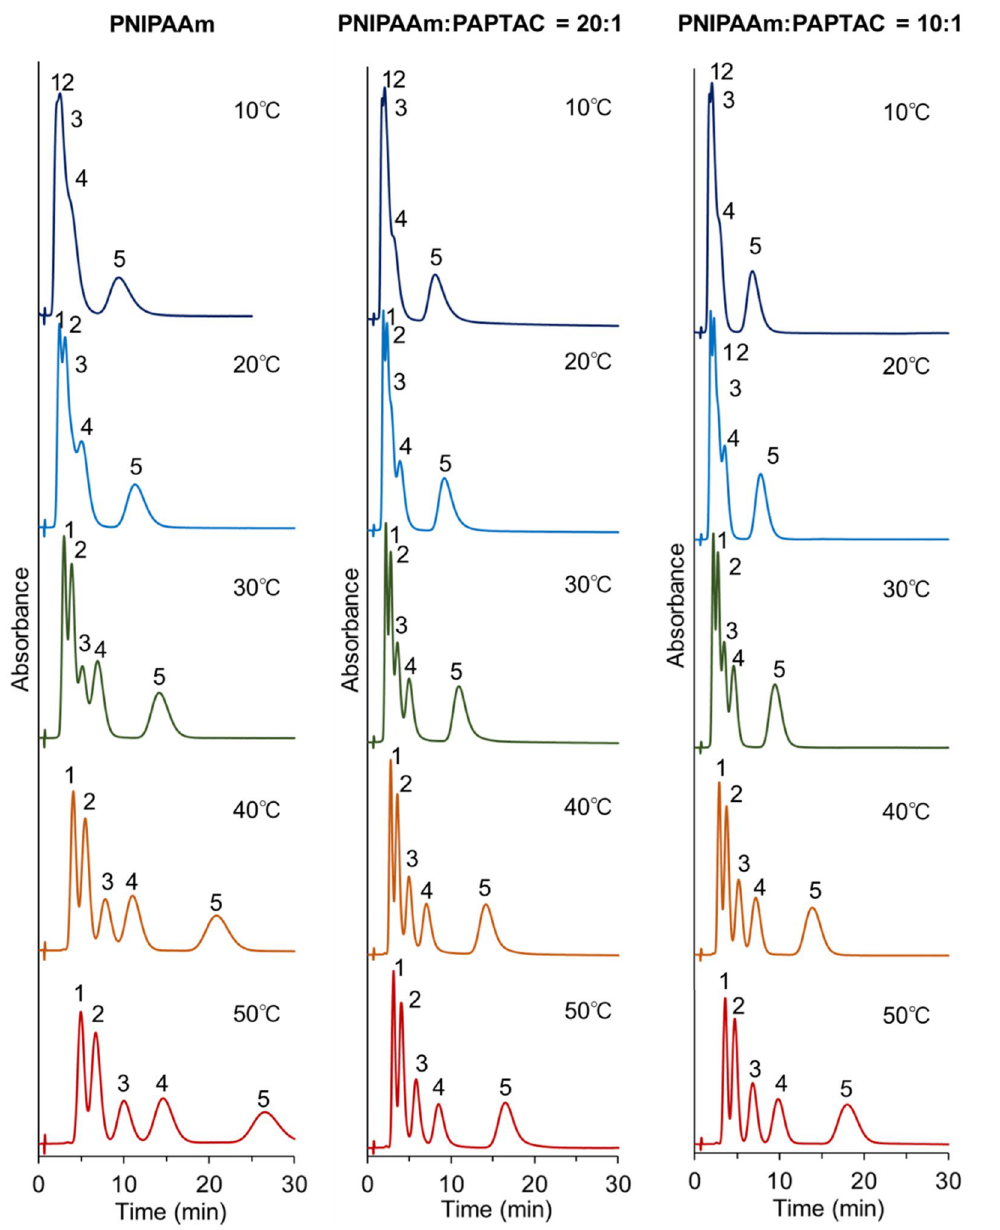
Figure 3. Chromatograms of hydrophobic steroids using prepared mixed-mode columns. The mobile phase was pure water. The flow rate of the mobile phase was 1.0 mL/min, and detection was measured at a wavelength of 260 nm. Peak 1 = hydrocortisone, peak 2 = prednisolone, peak 3 = dexamethasone, peak 4 = hydrocortisone acetate, and peak 5 = testosterone. (Figures were drawn Microsoft PowerPoint 2019 Version